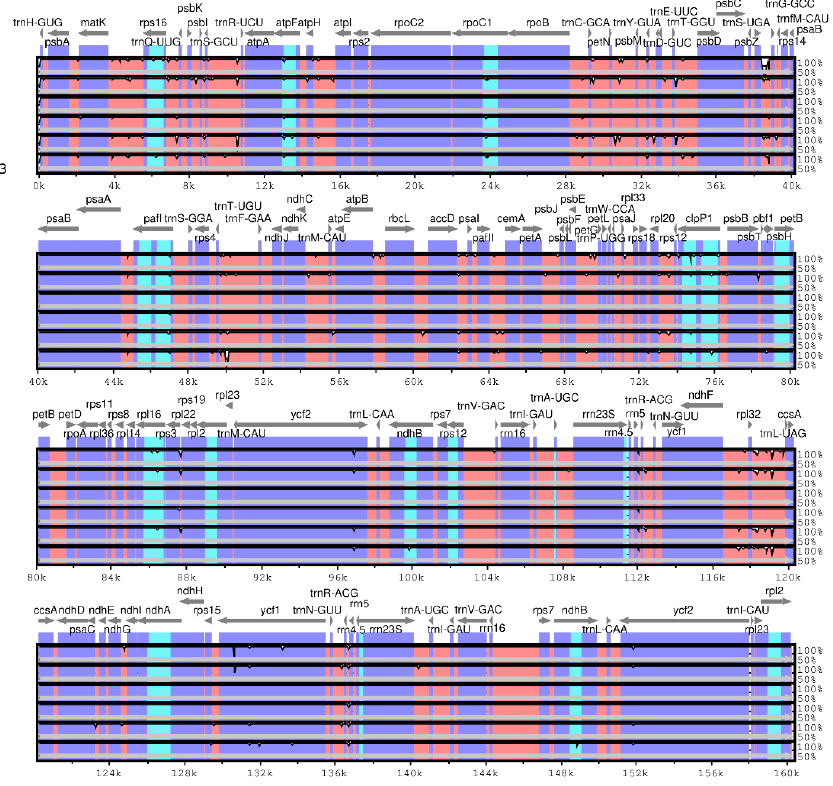
Figure 6. Sequence alignment of chloroplast genomes among six Ficus species. The x -axis shows the coordinates in the cp genome. The y -axis shows the recognition percentage (50% to 100%).